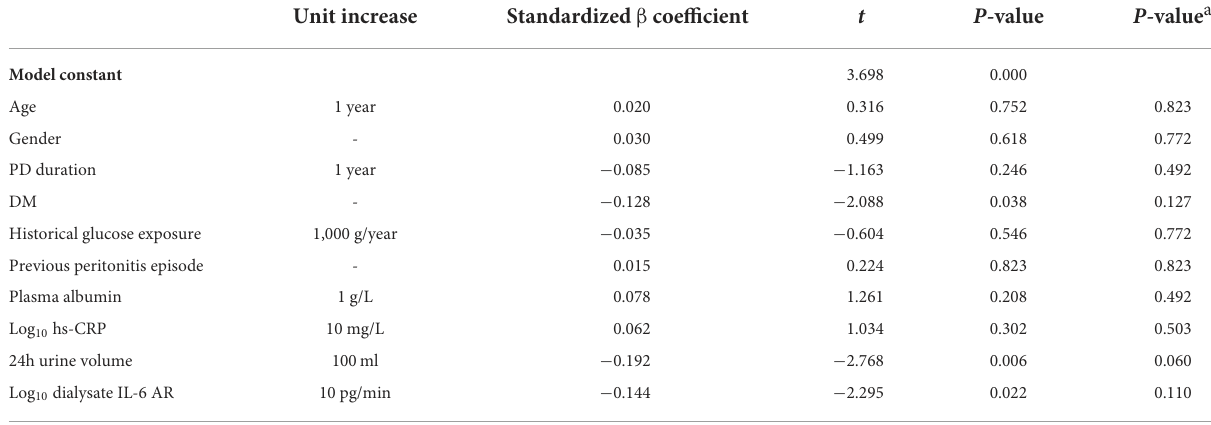
TABLE 2 Association of log 10 dialysate IL-6 AR and 24h urine volume with UF capacity at baseline. Unit increase Standardized β coefficient